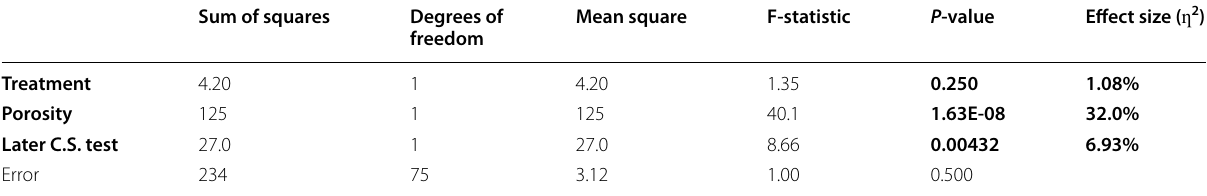
Table 2 ANOVA to explain changes in compressive strength – variables are treatment, porosity values and late compressive